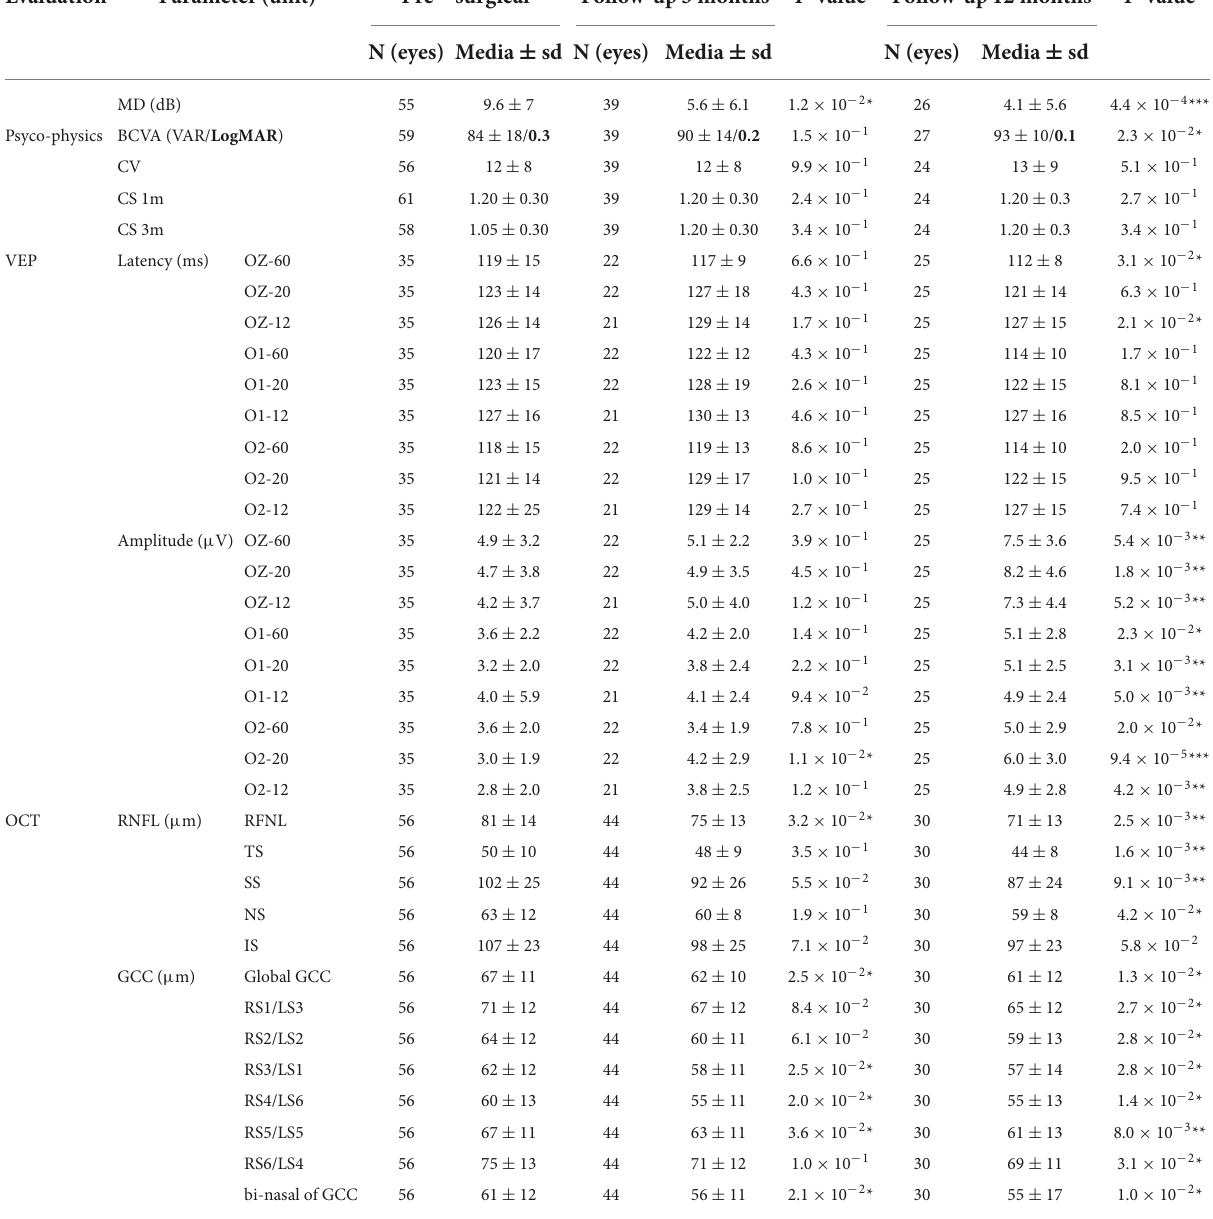
TABLE 3 Neuro-ophthalmological follow-up of patients with pituitary macroadenoma.